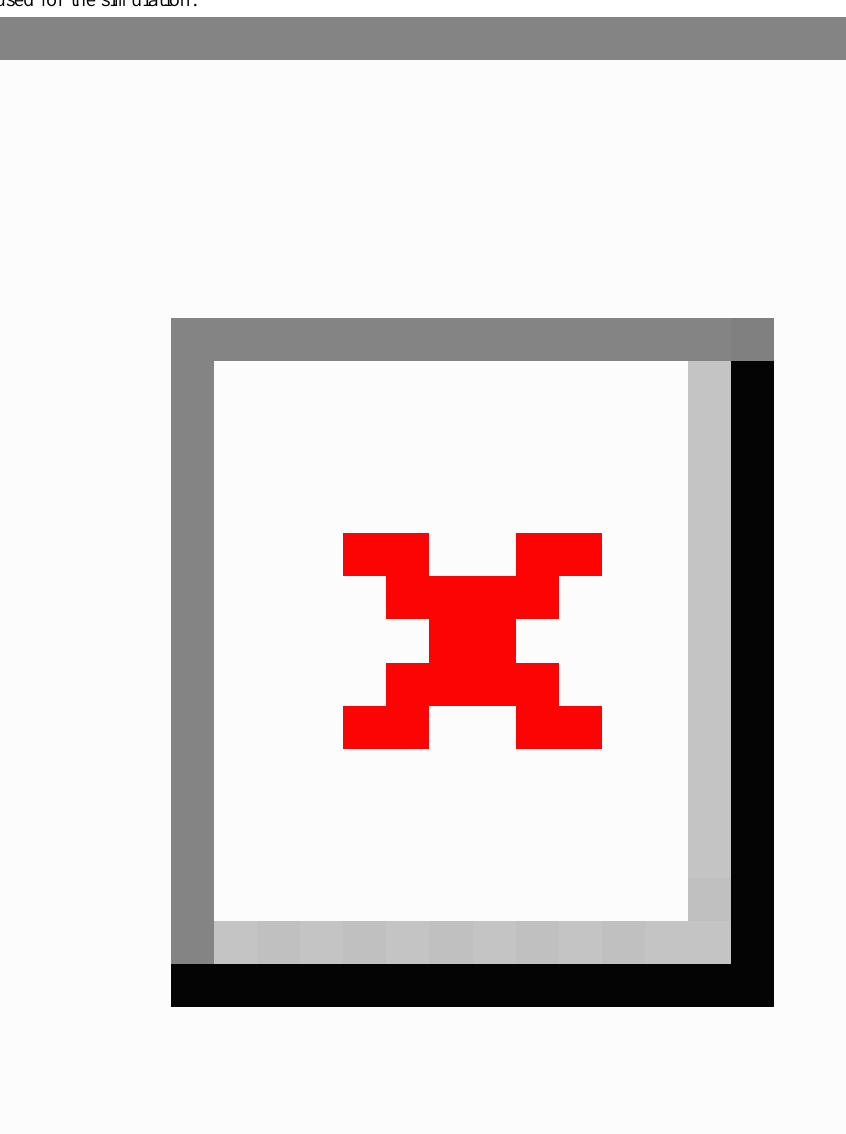
Figure 5. Simulation of positivity ratio compared with observed PCR (polymerase chain reaction) tests. Model PART1 with the same parameter values as in Figure 3 was used for the